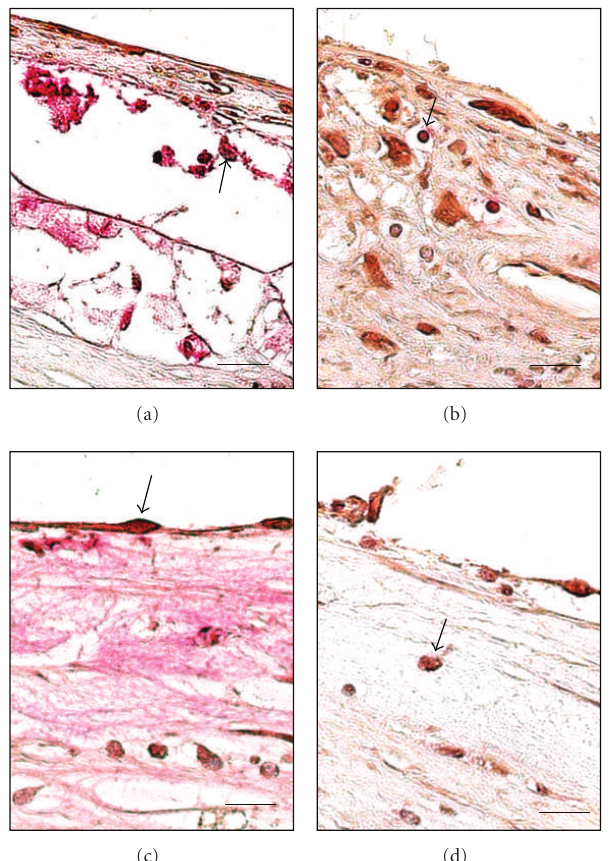
Figure 3: Double immunostaining of EphB2 and others in human AAA. EphB2 was stained with DAB (brown), the others with New Fuchsin (red). Bars, 20 μ m.